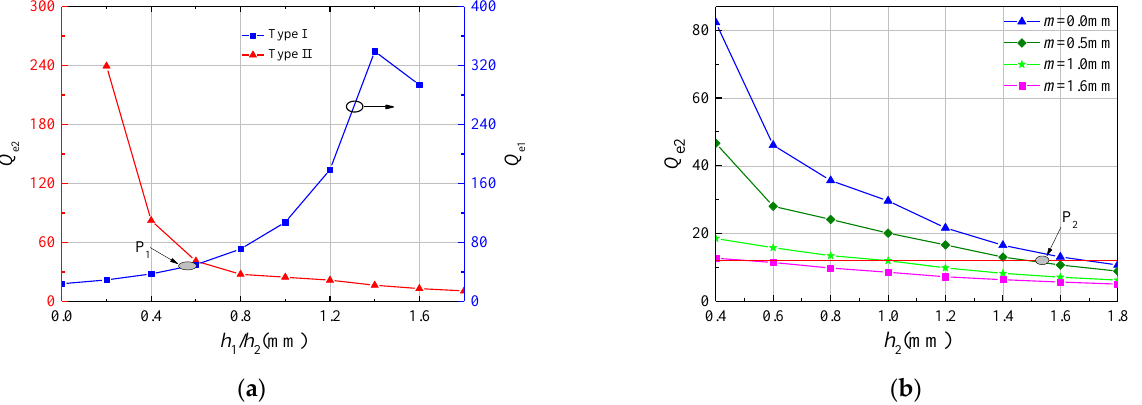
Figure 9. The external quality factor of the diplexer. ( a ) Q e1 ( Q e2 ) with different h 1 ( h 2 ); ( b ) Q e2 with different h 2 when m definite.